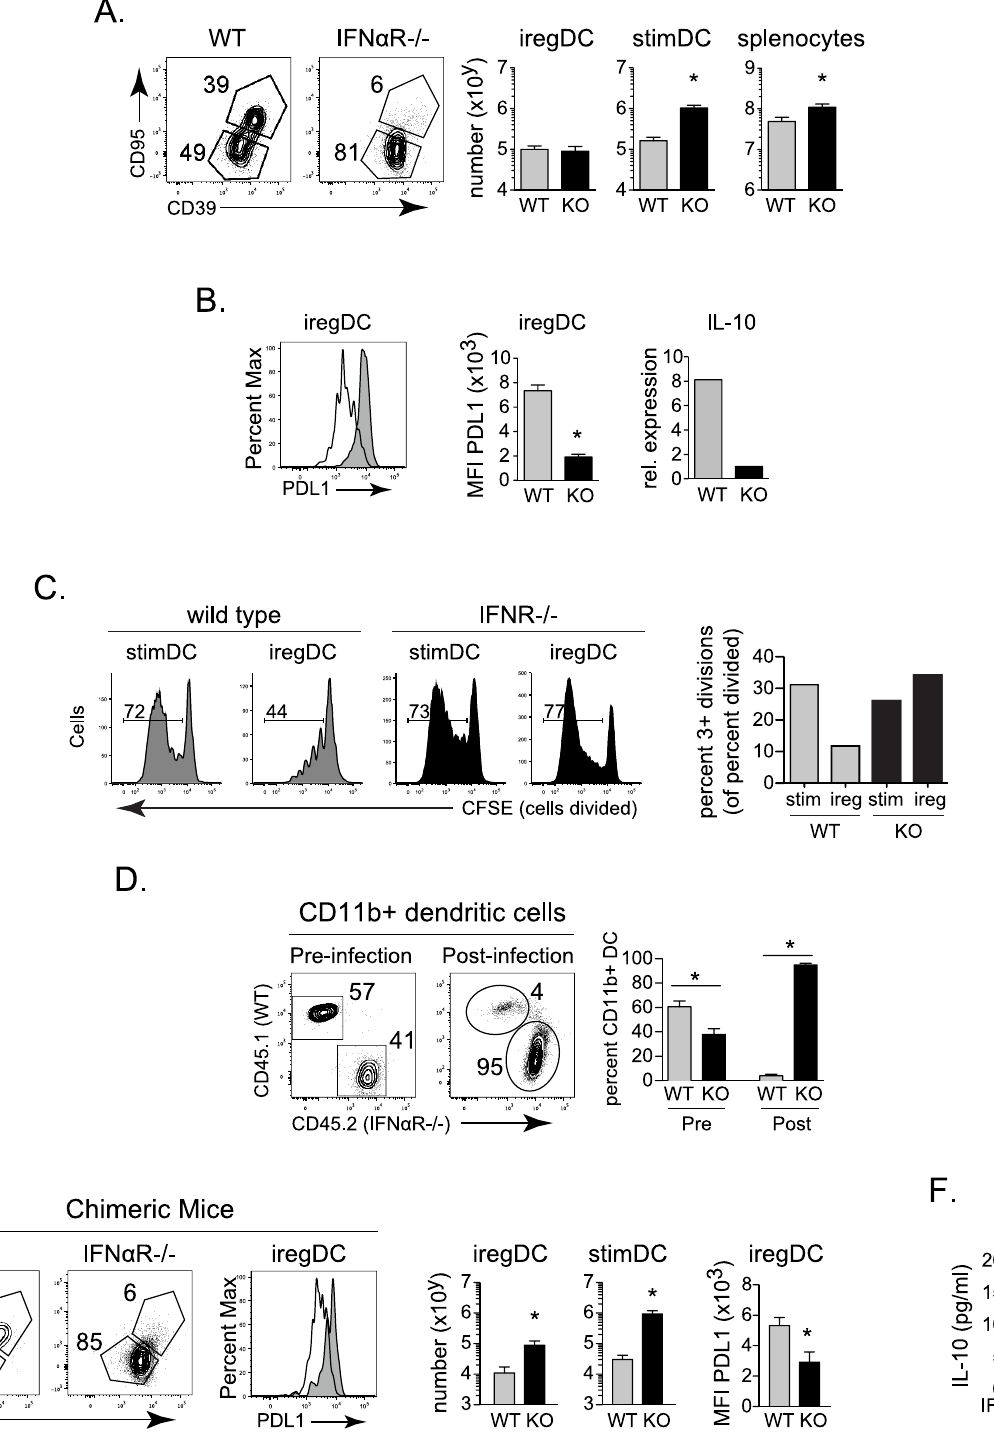
Fig 3. Two-pronged mechanism of IFN-I mediated immunosuppression: IFN-I programs iregDC suppressive functions and limits stimDC generation. A. CD39 and CD95 expression by splenic CD11b+ DCs from WT and IFN α R-/- mice at day 9 after LCMV-Cl13 infection. Bar graphs indicate the number of iregDC (CD39+, CD95+), stimDC, and total splenocytes. B. Histogram shows PDL1 expression on iregDCs from WT (grey) and IFN α R-/- (white) mice. Bar graphs show quantification of PDL1 expression (MFI) and IL-10 RNA by iregDC from WT and IFN α R-/- mice at day 9 of LCMV-Cl13 infection. To obtain sufficient cell numbers for the IL-10 RNA analysis, iregDC and stimDC were sorted from a pool of 8 mice. Data for IL-10 RNA analysis show one of two